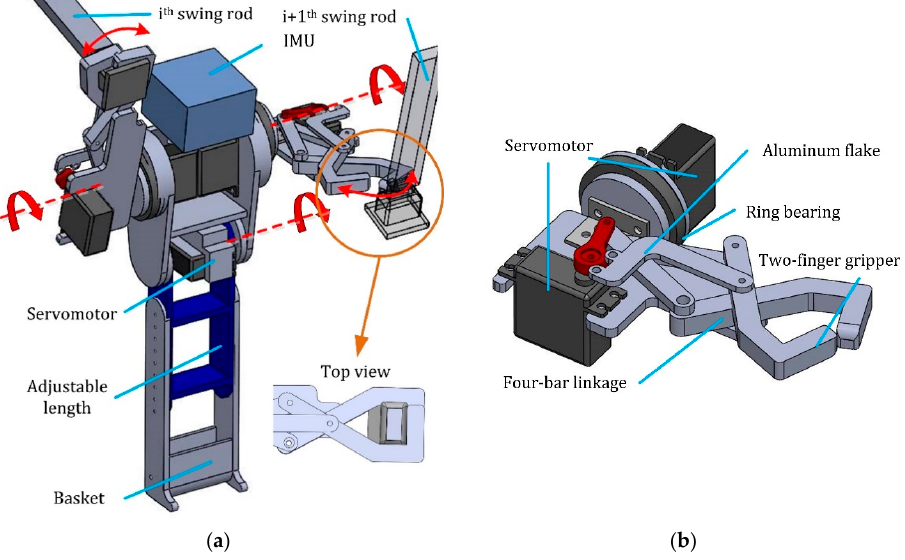
Figure 2. ( a ) A computer-aided drafting (CAD) drawing of the whole MonkeyBot and ( b ) the design of the right hand-arm.